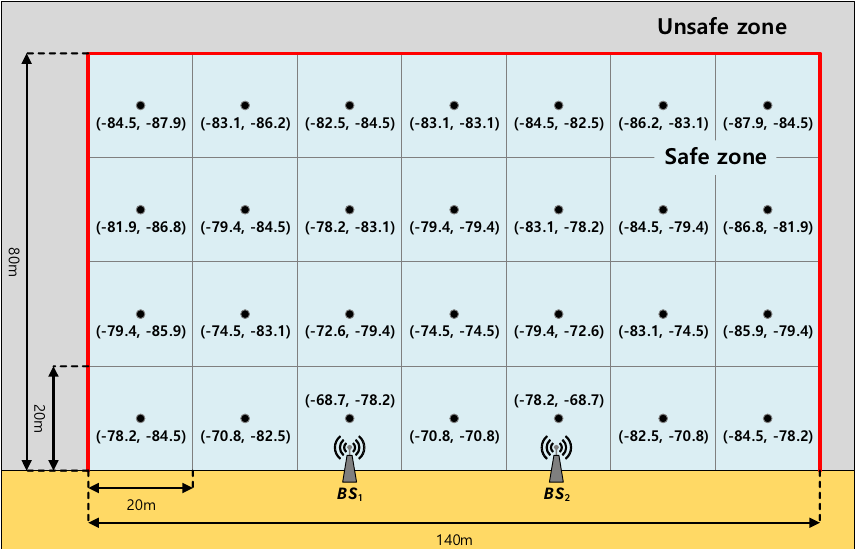
Figure 5. The Received Signal Strength (RSS) map